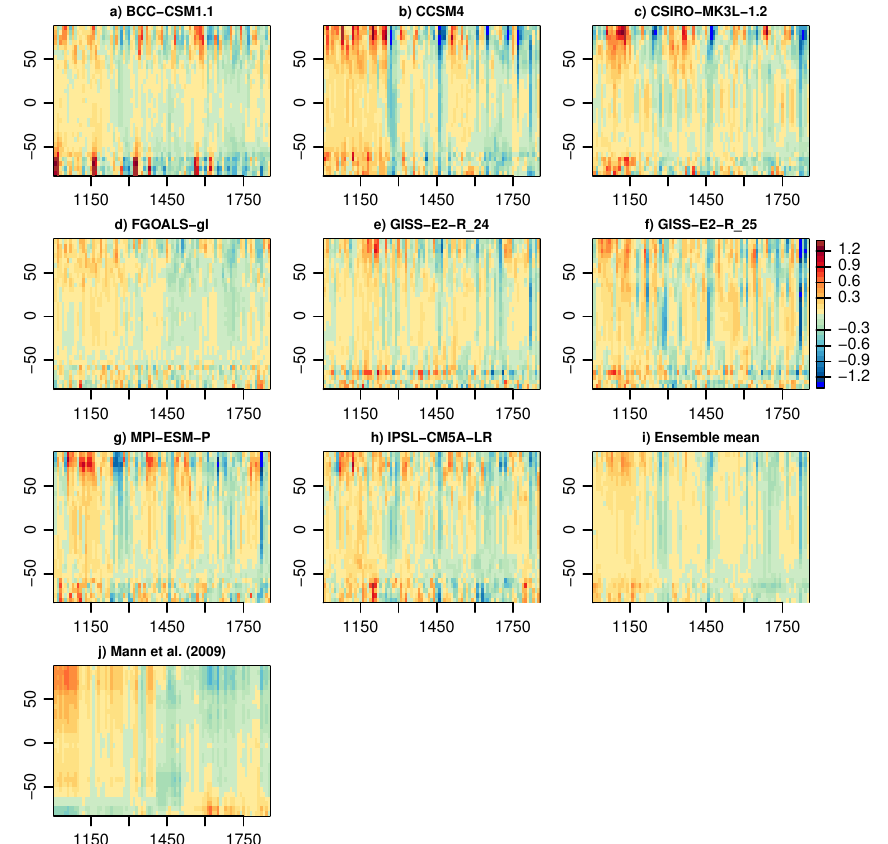
Fig. 4. Time–latitude plots of full-field zonal mean temperature anomalies (in K) with reference to the analysis period. See panel titles for individual simulations. Ensemble mean in (i) and reconstruction in (j)